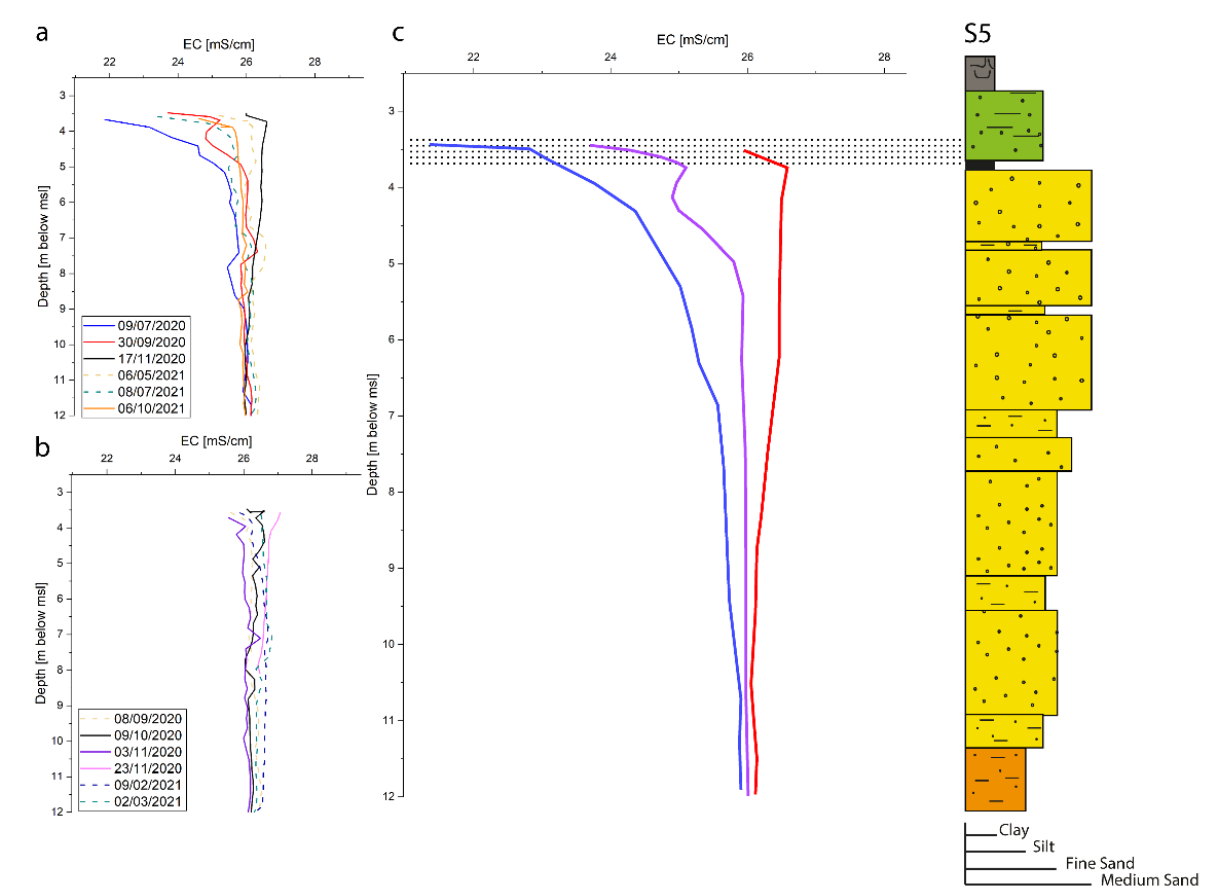
Figure 11. EC profiles collected in S5 well. Panels ( a , b ) show the configurations assumed by the EC curve during the observed period. The model of panel ( c ) summarizes the configurations and compares them with the stratigraphic section, outlining the sedimentary constraint (dotted area) existing in the subsoil surrounding the monitoring point.